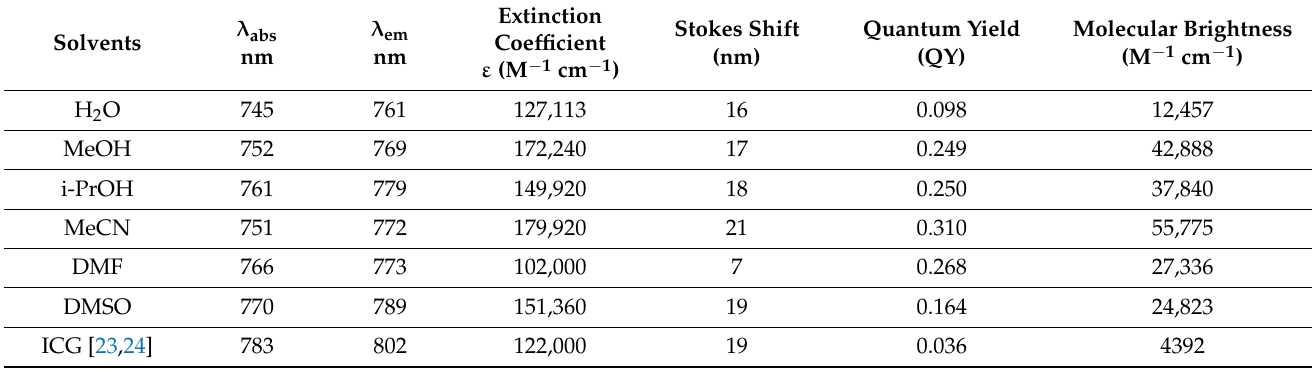
Table 2. Spectral characteristics of ERB-60 in polar protic and aprotic solvents (optical properties of ICG are in methanol).